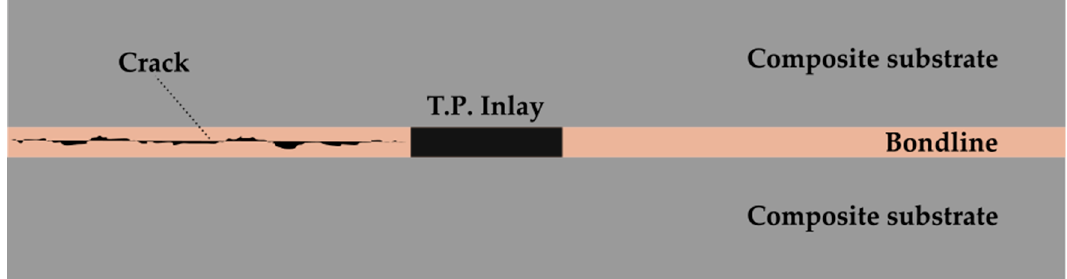
Figure 1. The hybrid bondline concept with embedded thermoplastic inlays.